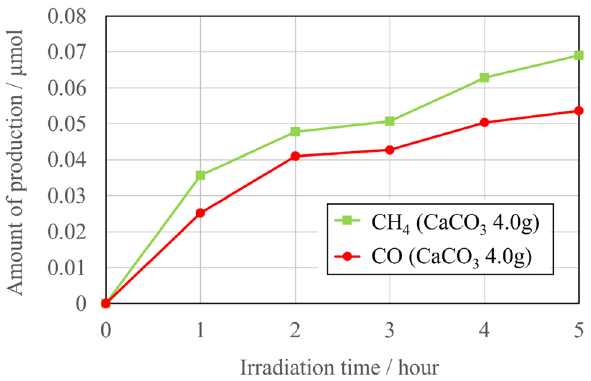
Fig. 13 Concentrations of CO and CH diation time for the AuNP/TiO